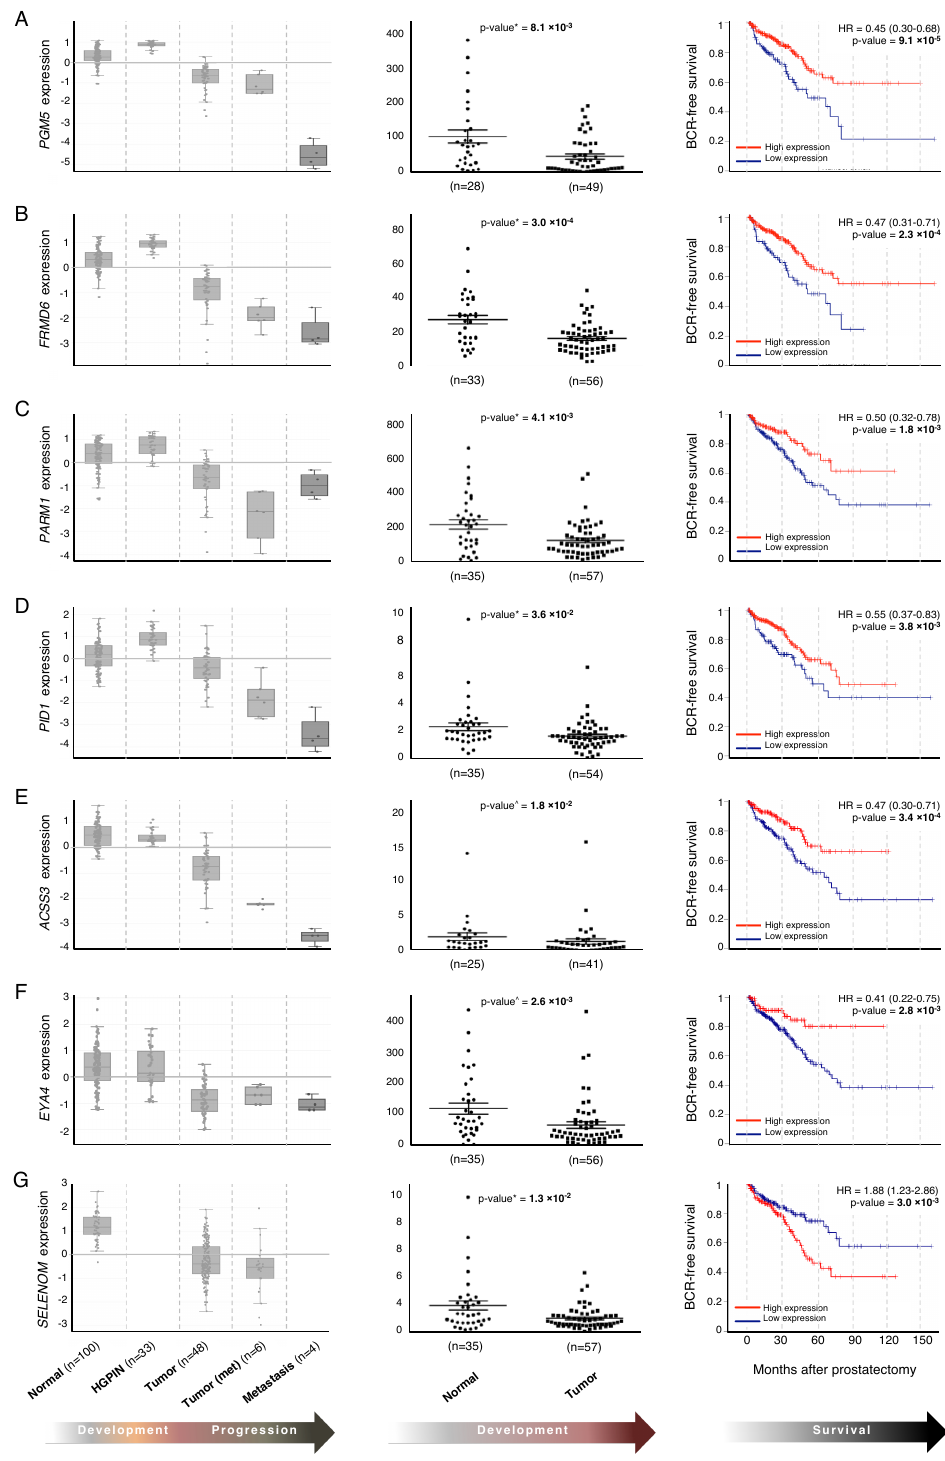
Figure 4. Genes identified by the integrative analysis validate in a clinical cohort. Predicted in silico expression patterns across PC development and progression stages for 7 experimentally validated genes (left panels), including ( A ) PGM5, ( B ) FRMD6, ( C ) PARM1, ( D ) PID1, ( E ) ACSS3, ( F ) EVA4 and ( G ) SELENOM, which were validated in the clinical cohort (middle panels) and stratified TCGA patients into prognostic groups based on low vs. high expression levels (right panels). The in silico expression profiles are based on combined data from 5 Affymetrix HG U133 Plus 2.0 datasets containing 191 samples representing all biological groups used for PC MAM construction. Only genes previously unreported in PC are shown. ˆ Mann-Whitney; * unpaired t-test; HR: hazard ratio; BCR: biochemical